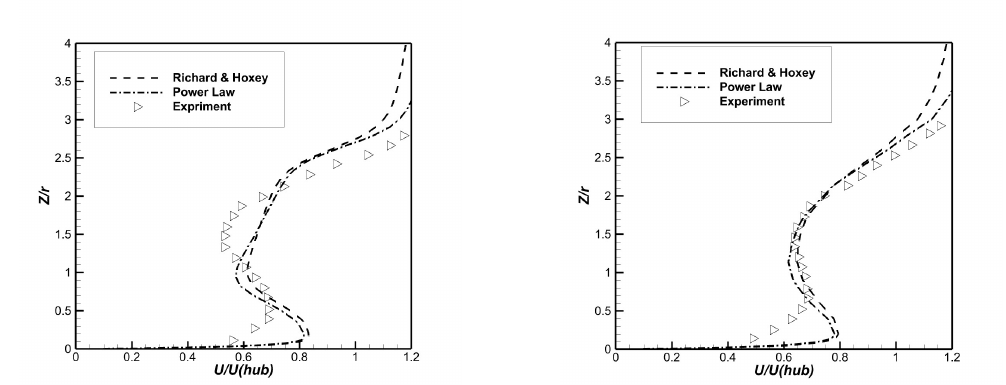
Figure 4. Power law and logarithmic velocity profile in the near wake at 3 D ( left ) 5 D ( right ).